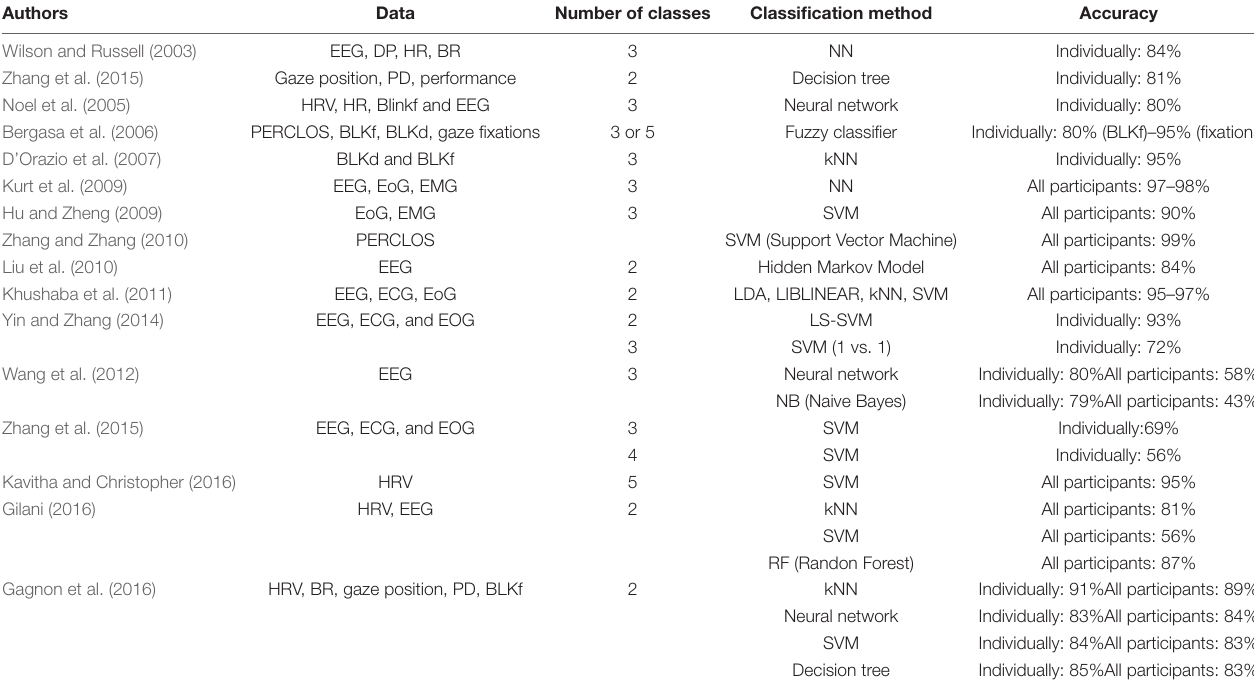
TABLE 1 | Methods applied to OFS classification (Hancock et al., 1995; Noel et al., 2005; Bergasa et al., 2006; D’Orazio et al., 2007; Hu and Zheng, 2009; Kurt et al., 2009; Liu et al., 2010; Zhang and Zhang, 2010; Khushaba et al., 2011; Sahayadhas et al., 2012; Wang et al., 2012; Zhao et al., 2012; Bauer and Gharabaghi, 2015; Kavitha and Christopher, 2015, 2016; Zhang et al., 2015; Gagnon et al., 2016; Gilani,